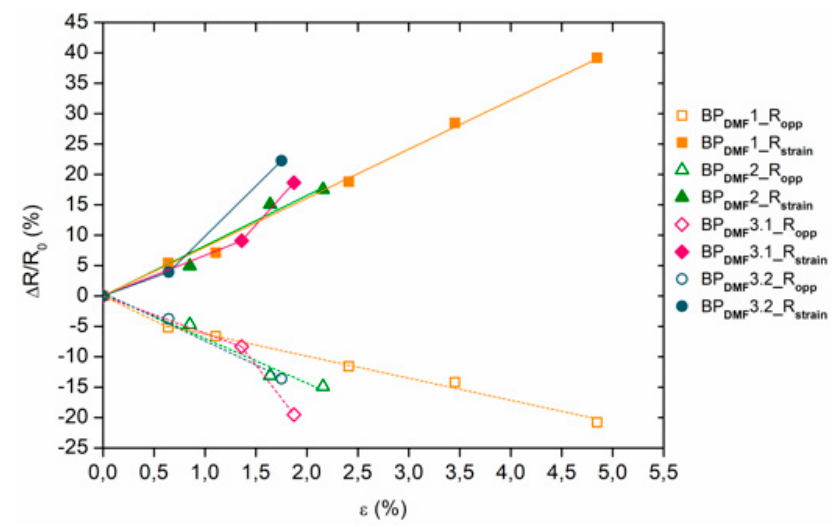
Figure 4. Relative electrical resistance ∆ R/R 0 as function of the strain ε for the BP DMF /PI samples (R strain and R opp values in axial strain and opposite (transverse) directions, respectively).